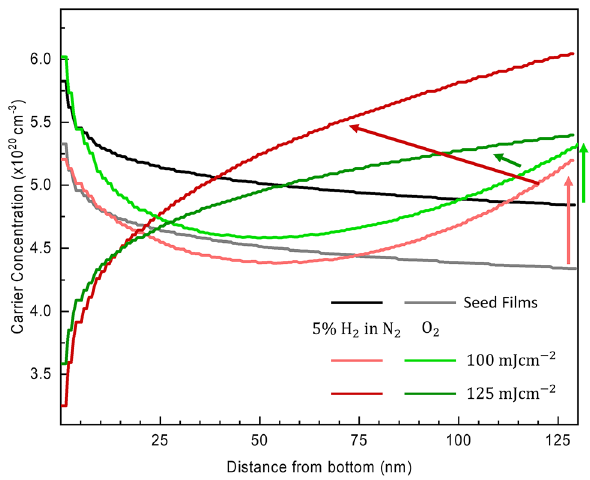
Figure 5. The optical carrier concentration as a function of the distance from the ITO/Si interface, N opt ( z ) , for two representative samples at different positions on the seed ITO film (grey and black line) and those subject to single-pulse ReLA at 100 mJcm − 2 (lighter shade) and 125 mJcm − 2 (darker shade) in both 5% H 2 in N 2 (red line) and 100% O 2 (green